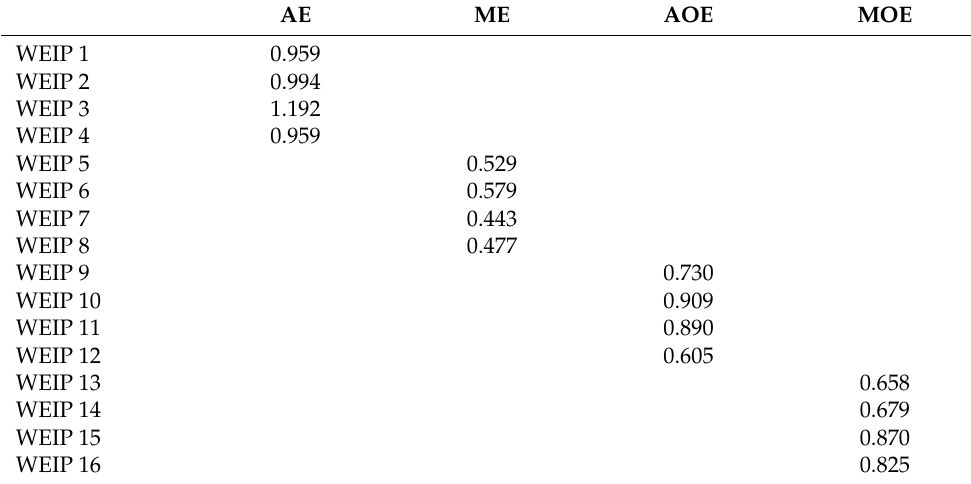
Table 5. Factor loading of the four-factor models.